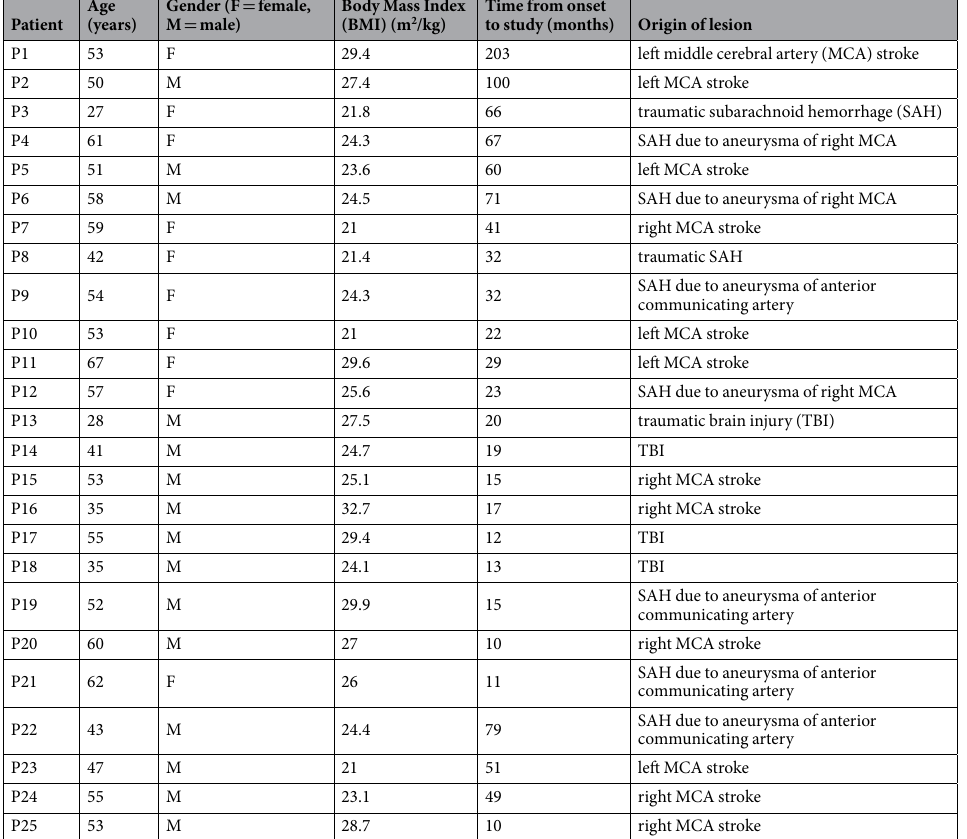
Table 1. Patients’ clinical data. The table lists patients’ age, gender, BMI, the time from onset to study as well as the origin of lesion. For the corresponding brain lesion pattern of each patient please refer to Supplementary Figure